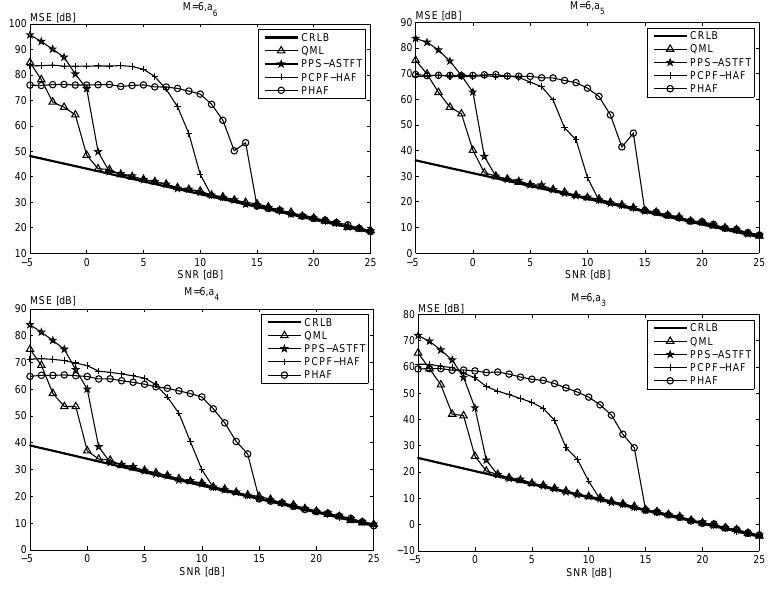
Figure 2. The MSE of the four highest order coefficients of the 6th-order PPS.